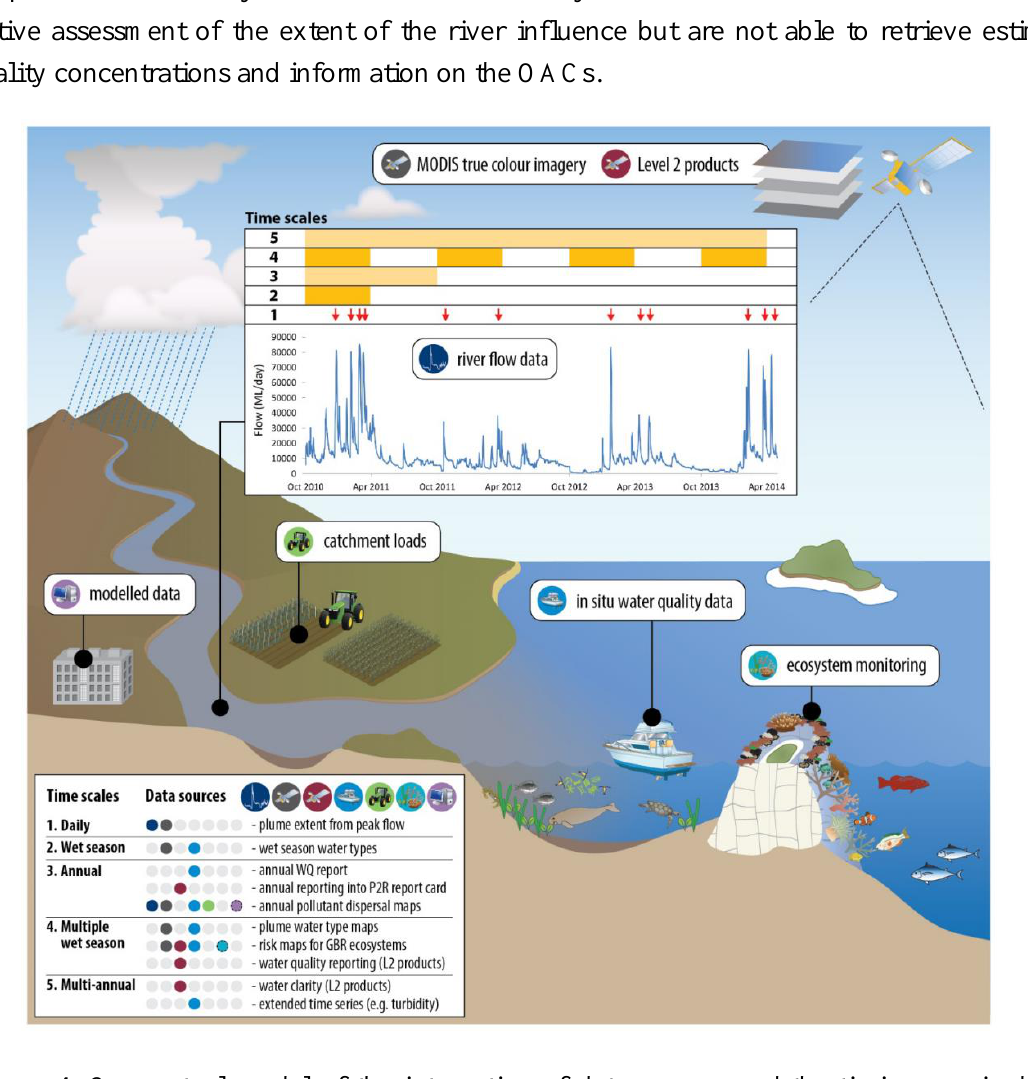
Figure 4 . Conceptual model of the integration of data sources and the timing required to produce water quality monitoring products for the GBR. RS (remotely-sensed) products are described by the time scales available (daily, wet season, annual, multiple wet season, and multiple annual) and by the source of data that is required for the development of the product, including RS data (Level-1, Level-2), catchment load data, in situ data, modelled data, and ecosystem information (seagrass and coral reefs) for the